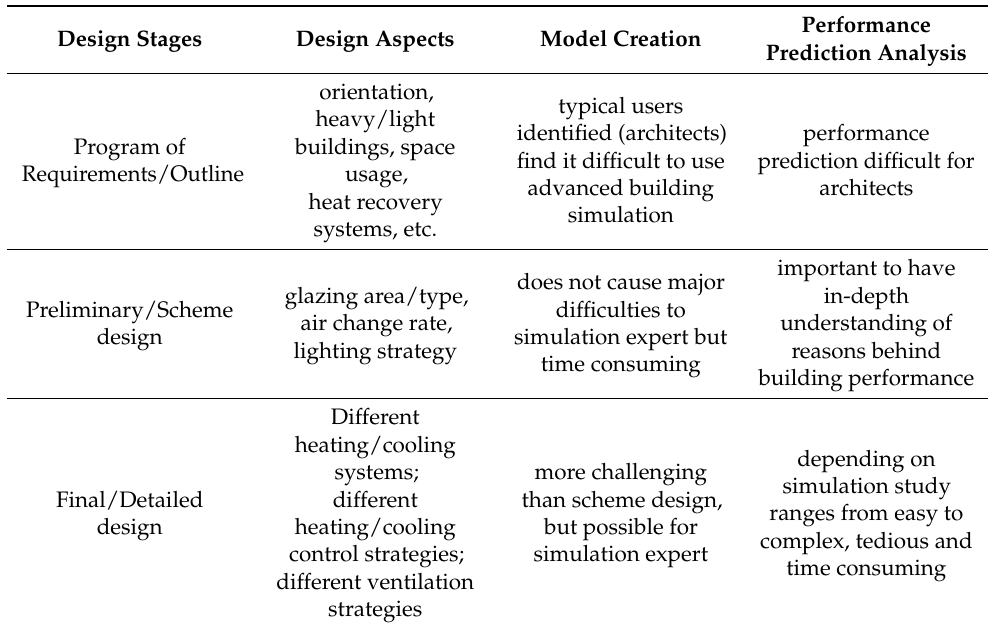
Table 1. Problems of performing BPS in the design stages